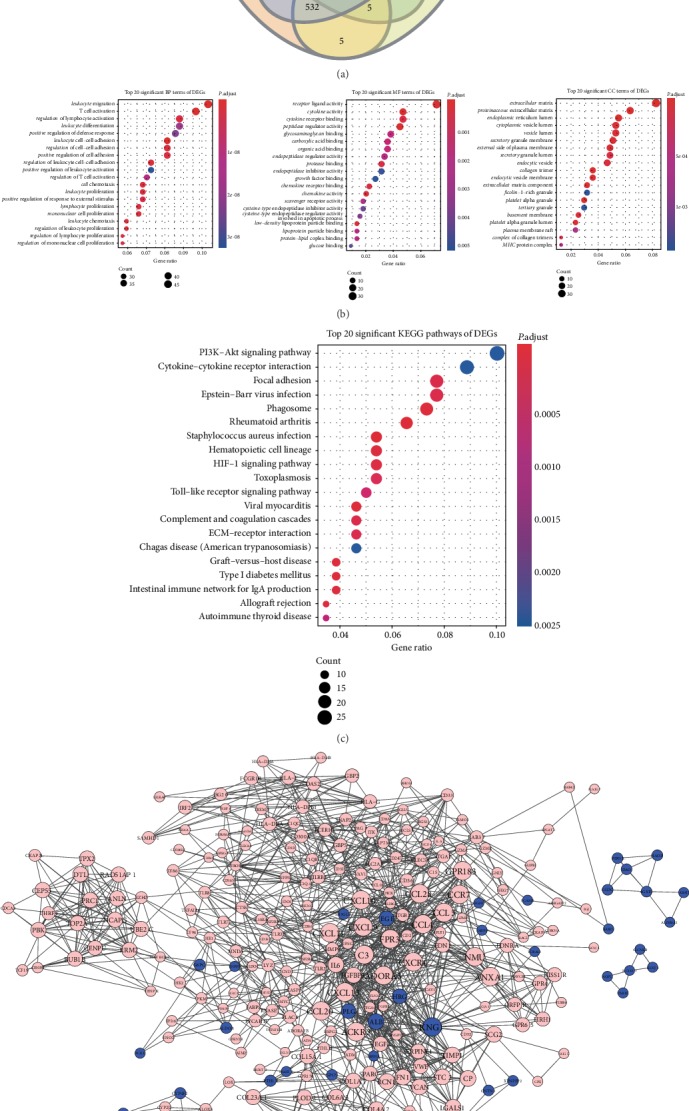
Identification and functional enrichment analyses of 500 DEGs. (a) Constructing a Venn diagram in four comparison groups with the cut-off criteria of ∣log2FC∣ > 2 and an adjusted P value < 0.05. (b) GO enrichment analysis showing the top 20 terms of the BP, MF, and CC categories. (c) Top 20 significant KEGG pathways. (d) PPI networks of 500 DEGs. Pink nodes indicate upregulated DEGs and blue nodes indicate downregulated DEGs.